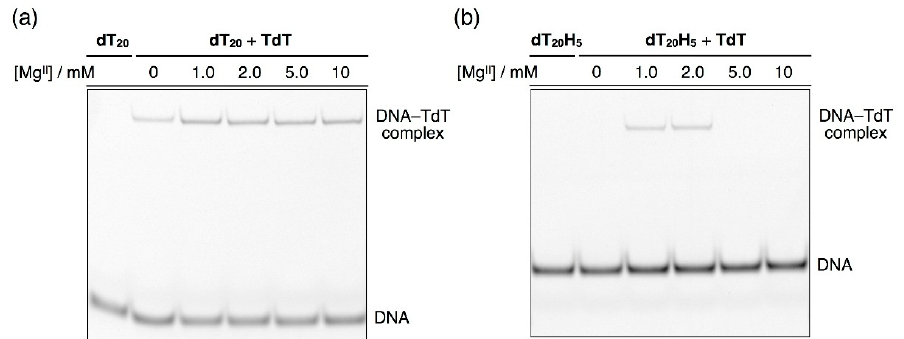
Figure 5. Effects of Mg II concentrations on the binding of TdT with ( a ) natural DNA primers (5’-FAM-dT 20 -3 ′ ) and ( b ) artificial ligand-bearing DNA primers (5 ′ -FAM-dT 20 H 5 -3 ′ ). EMSA was performed using an EDTA-free buffer at 10–15 °C. 5 ′ -FAM-dT 20 -3 ′ or 5 ′ -FAM-dT 20 H 5 -3 ′ : 5.0 µM, TdT: 2 U/µL, MgCl 2 : 0, 1.0, 2.0, 5.0 and 10 mM.